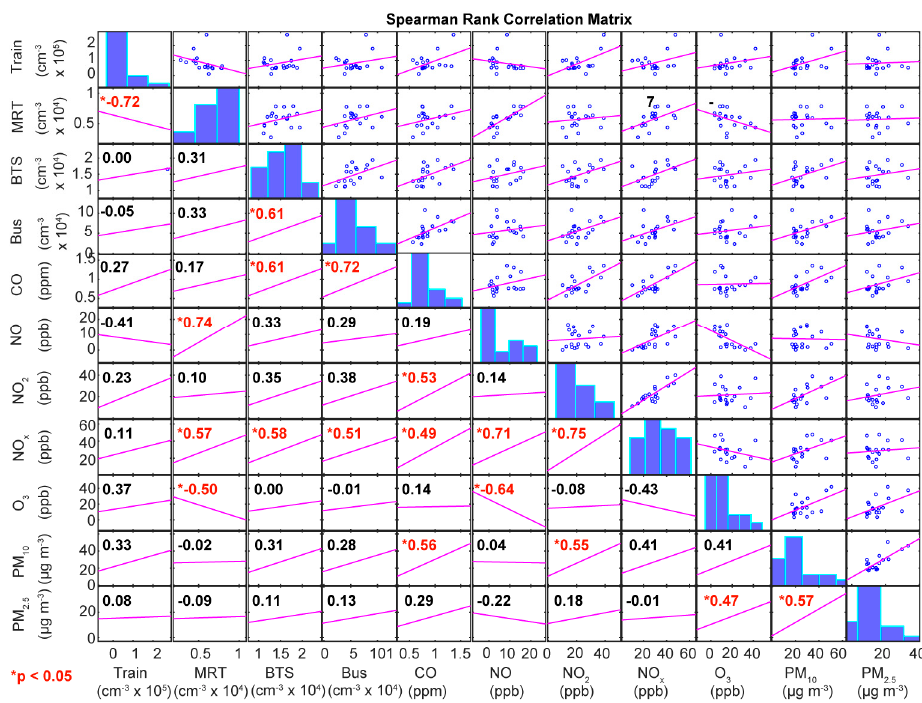
Figure 4. Spearman’s rank correlation matrix of average particle concentrations measured on the train, MRT, BTS and bus alongside contemporaneous 5 h averages of pollutants measured at the PCD at the PR department, central Bangkok. The top right panels show the sca tt er plot of the pair ov values and purple lines represent a least squares reference line, numbers in the bo tt om left half indicate the Spearman rank correlation coe ffi cient and red numbers (with asterisks)indicate signi fi - cant correlations ( p < 0.05). The bar charts in the central diagonal represent the distribution of the variable as a histogram.